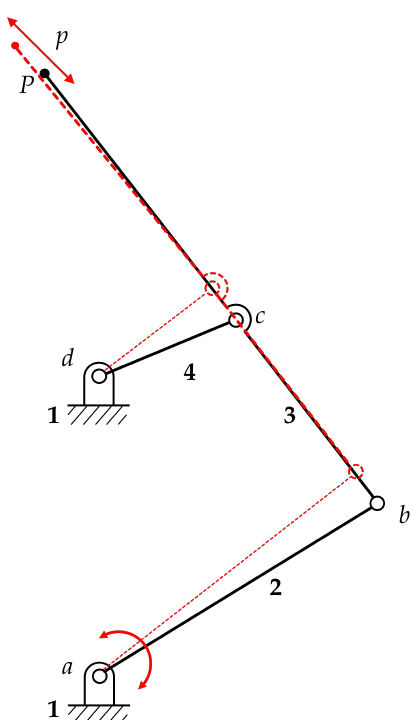
Figure 1. PRBM corresponding to half of the presented structure with two configurations, producing a 45 ◦ path.